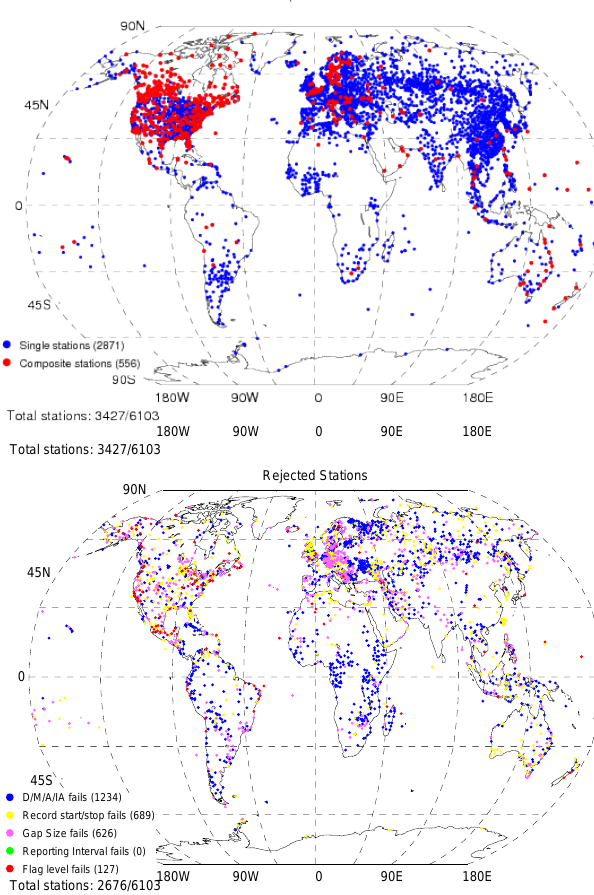
Fig. 20. The results of the final filtering to select climate quality stations. Top: the selected stations which pass the filtering, with red for composite stations (556/3427). Bottom: the rejected stations. Of these, 1234/2676 fail to meet the daily, monthly, annual or interannual requirements(D/M/A/IA);689/2676beginafter1980orendbefore2000;626/2676haveagapexceedingtwoyearsafterthedaily,monthly andannualcompletenesscriteriahavebeenapplied;and127failbecauseoneofthethreemainvariableshasahighproportionofflags.